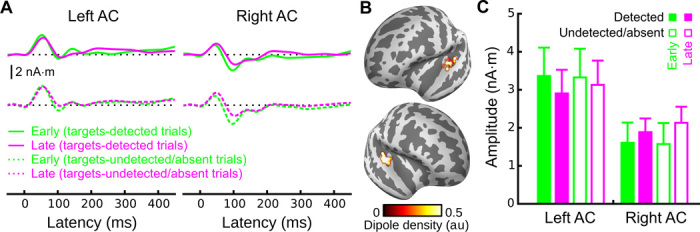
Neural activity elicited by masker tones, with emphasis on the P1 latency range.(A) Grand-average MxNE solutions for responses elicited by masker tones for targets-detected trials (solid traces; top) and targets-undetected/targets-absent trials (dotted traces; bottom) for early (green) and late (magenta) time intervals. Epochs for targets-detected trials were created by splitting those trials into two time intervals (before and after target detection). Epochs for targets-undetected/targets-absent trials were created by splitting those trials into two time periods based on the average detection time of the targets-detected trials. (B) Corresponding dipole locations. (C) Quantified P1 amplitudes in response to masker tones both before (green) and after (purple) detection of the standard stream. Closed (open) bars are for targets-detected (targets-undetected) trials. A three-way ANOVA with hemisphere, target detection, and time interval as factors revealed significant two-way interactions between hemisphere and interval (F1,19 = 9.2, P < 0.01) as well as a marginally significant two-way interaction between target detection and interval (F1,19 = 3.3, P = 0.09). However, subsequent paired comparisons did not show significant effects of the time interval on either left AC or right AC in the direction one would expect based on an attentional account of the data (table S2). A similar pattern of results was observed when the more anterior MMN-defined source space was used (cf. figs. S4 and S6).